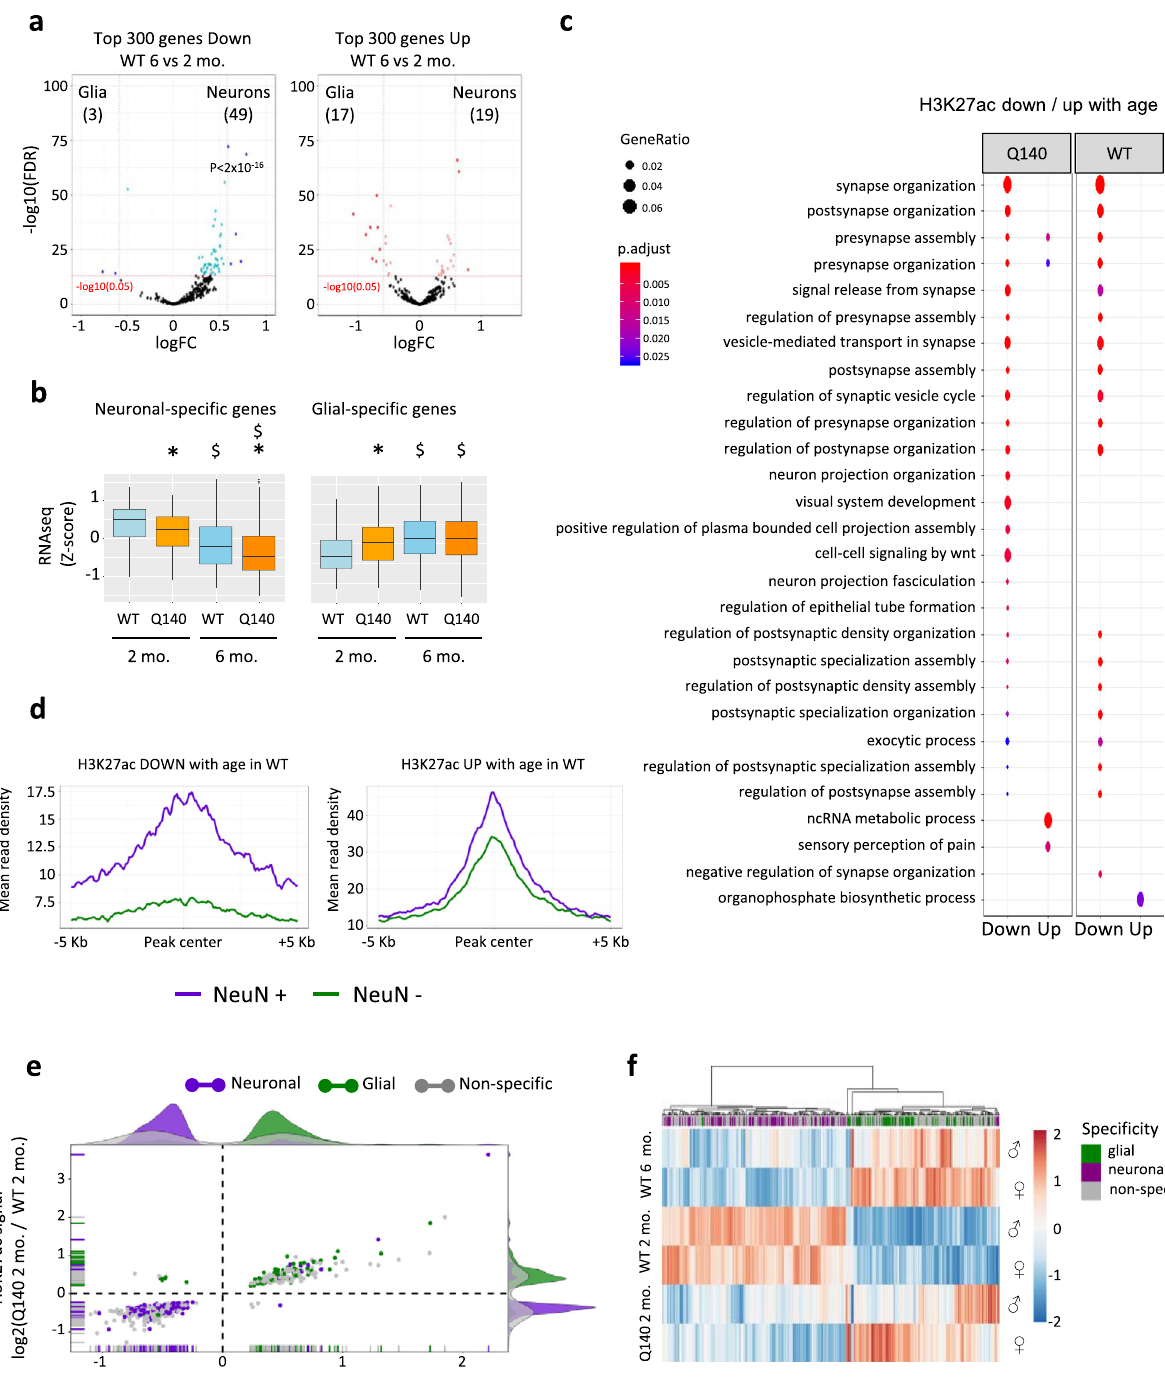
Age-related epigenetic remodelling of neuronal- and glial- speci fi c enhancers is accelerated in HD Q140 mice . We then determined whether acceleration of age-related transcriptional changes in HD mouse striatum would associate with age-related epigenetic mechanisms. Age was the major component of varia- bility of H3K27ac, RNAPII and H3K27me3 ChIPseq data gen- erated on Q140 and WT striata at 2 and 6 months of age (Supplementary Fig. 13a). Moreover, GO analysis indicated that regions depleted in H3K27ac with age associated with neuronal functions in both WT and Q140 samples, whereas functional signatures of regions increased in H3K27ac with age were less